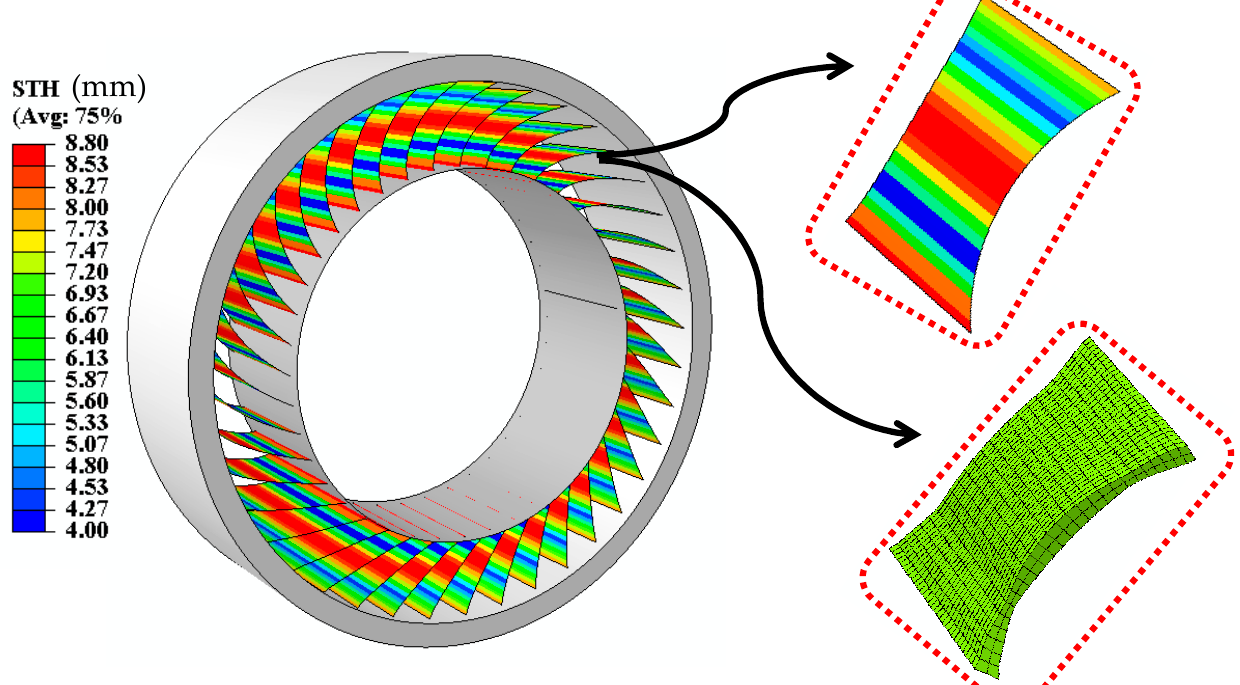
Figure 12. Optimized thickness distribution for tire-radius direction.